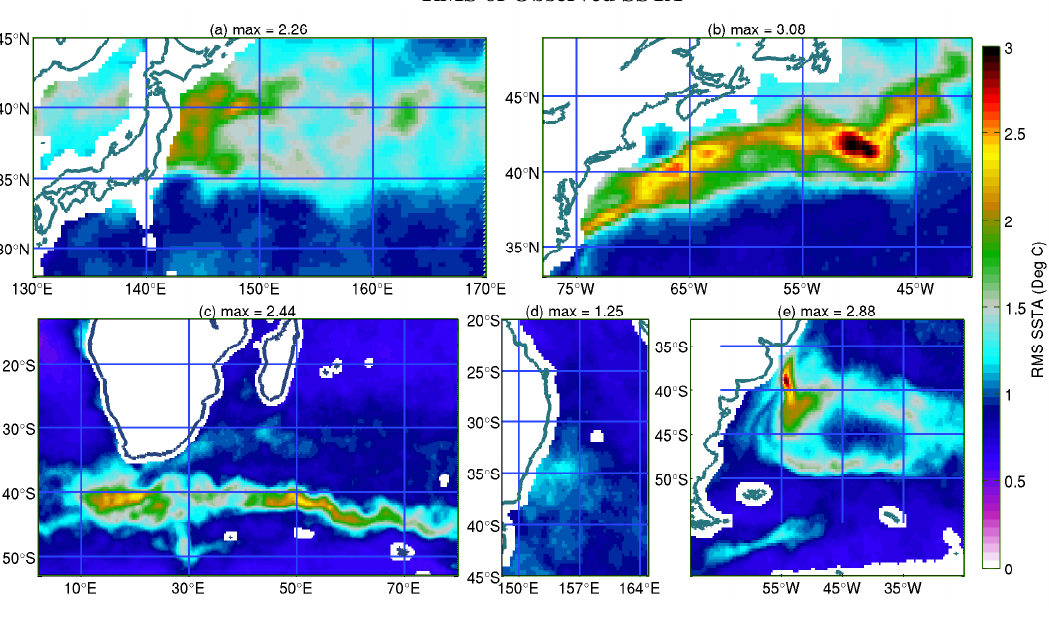
Fig. 14. As for Fig. 13, except for Fig. 14. As for Figure 13, except for observations.